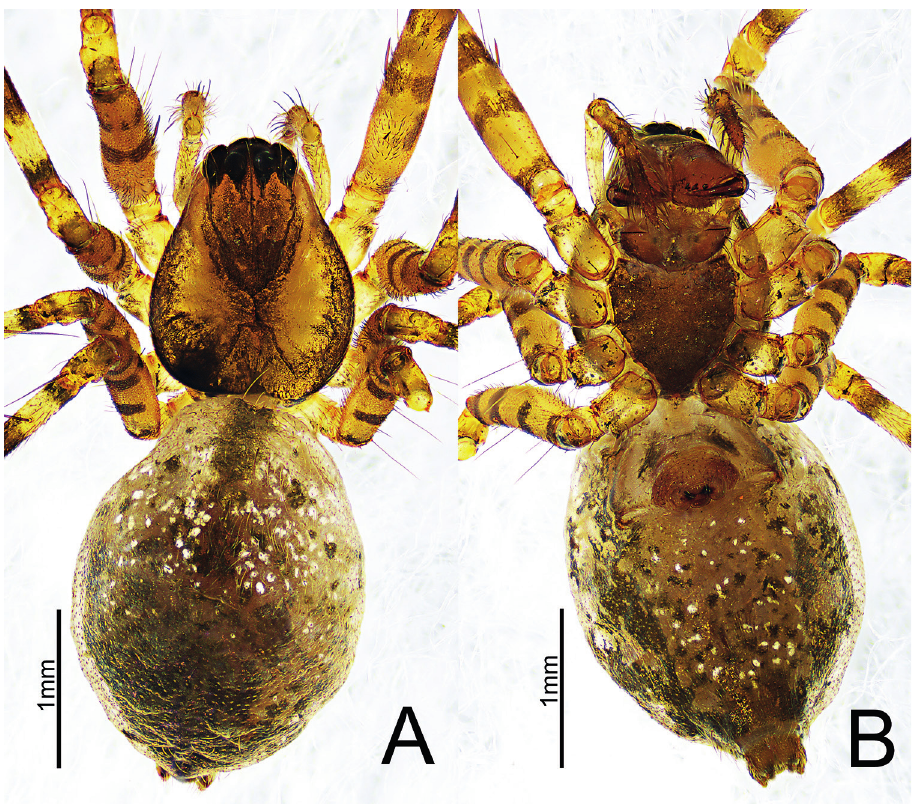
Figure 2. Himalaphantes arcuatus sp. nov., holotype ♀ A habitus, dorsal view B habitus, ventral